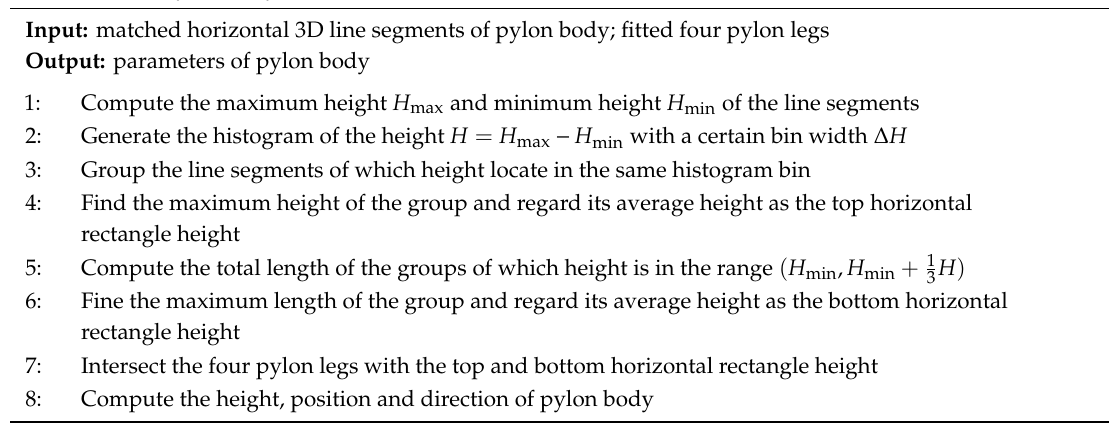
Algorithm 1. Pylon Body Parameter